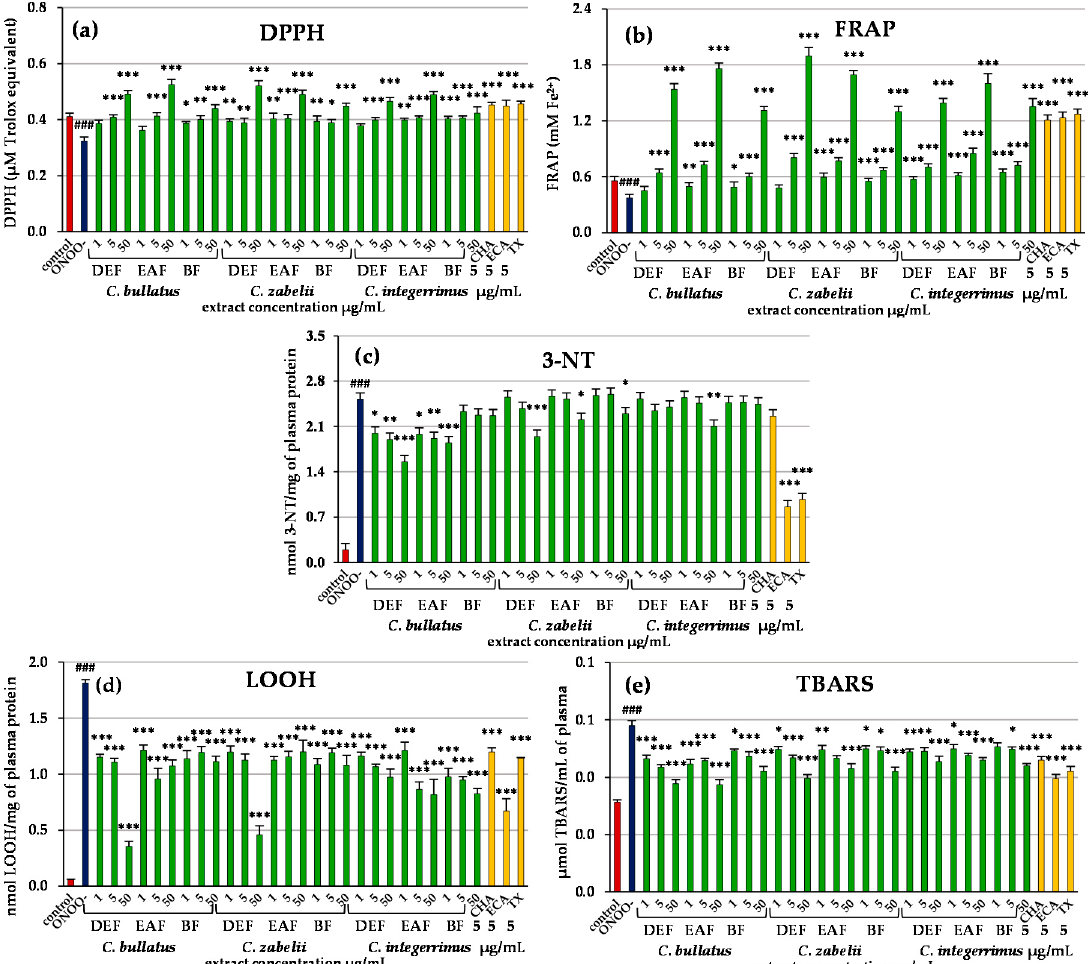
Figure 3. Effects of Cotoneaster leaf extracts on human plasma exposed to oxidative stress: ( a ) free radical scavenging ability, DPPH; ( b ) influence on ferric reducing ability of plasma, FRAP; ( c ) effects on the nitration of tyrosine residues in plasma proteins and formation of 3-nitrotyrosine, 3-NT; ( d , e ) effects on the peroxidation of plasma lipids including ( d ), formation of lipid hydroperoxides, LOOH and ( e ), formation of thiobarbituric acid-reactive substances, TBARS. Results are expressed as means ± SE ( n = 5) for repeated measures: ### p < 0.001, for ONOO − -treated plasma (without the extracts) versus control (untreated) plasma, and * p < 0.05, ** p < 0.001, *** p < 0.001, for plasma treated with ONOO − in the presence of the investigated extracts (1–50 µg/mL) or the standards (5 µg/mL). Extracts: DEF, diethyl-ether fraction; EAF, ethyl acetate fraction; BF, n -butanol fraction. Standards: CHA, chlorogenic acid; ECA, ( − )-epicatechin; TX, Trolox ® . The exposure of the plasma to 100 µM ONOO − resulted also in oxidative/nitrative alterations of plasma proteins and lipids, as demonstrated by the increase ( p < 0.001, vs. the control plasma) in the